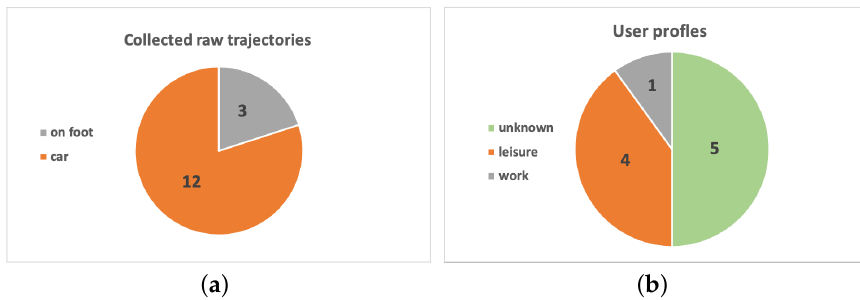
Figure 13. ( a ) Exhibits the quantity of collected data and users’ profiles. ( b ) Users’